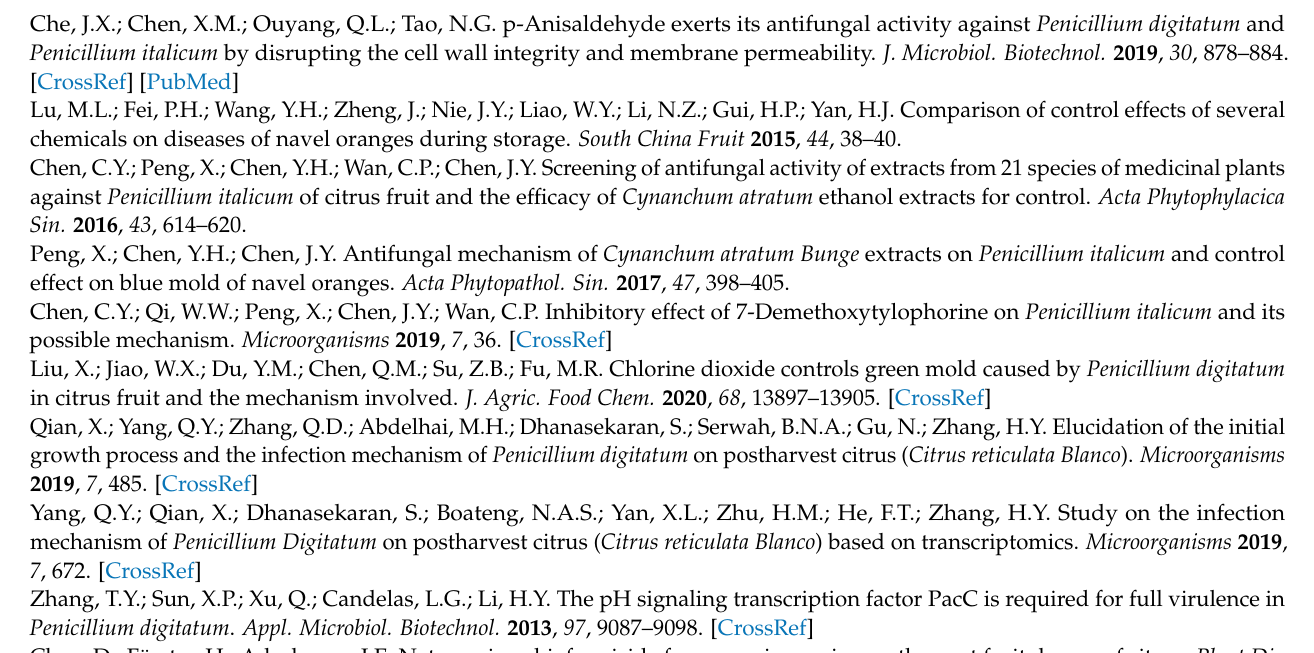
time; Table S2.3. The average water loss (%) of single fruit under green LED light illumination at different storage time; Table S2.4. The average water loss (%) of single fruit under blue LED light illumination at different storage time; Table S2.5. The average water loss (%) of single fruit under red LED light illumination at different storage time; Table S3.1. The average water loss (%) of single fruit of navel oranges treated by low-temperature plasma produced by oxygen ionization 3 min; Table S3.2. The average water loss (%) of single fruit of navel oranges treated by low-temperature plasma produced by oxygen ionization 6 min; Table S3.3. The average water loss (%) of single fruit of navel oranges treated by low-temperature plasma produced by air ionization 3 min; Table S3.4. The average water loss (%) of single fruit of navel oranges treated by low-temperature plasma produced by air ionization 6